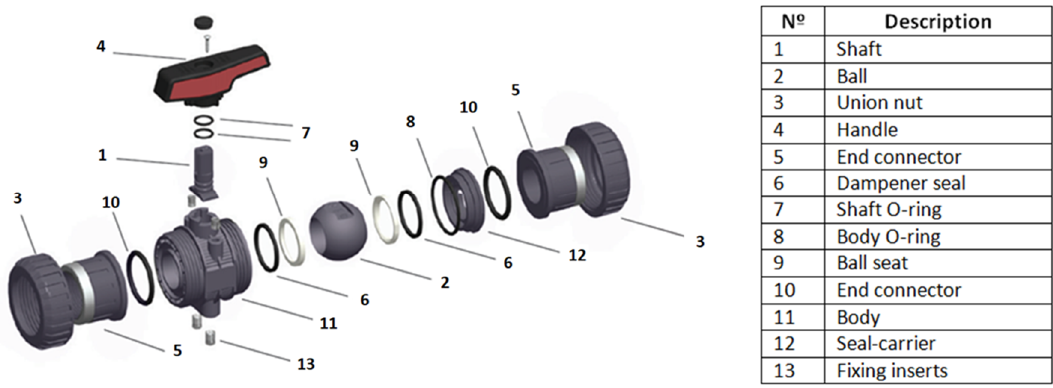
Figure 1. Exploded view of ball valve.